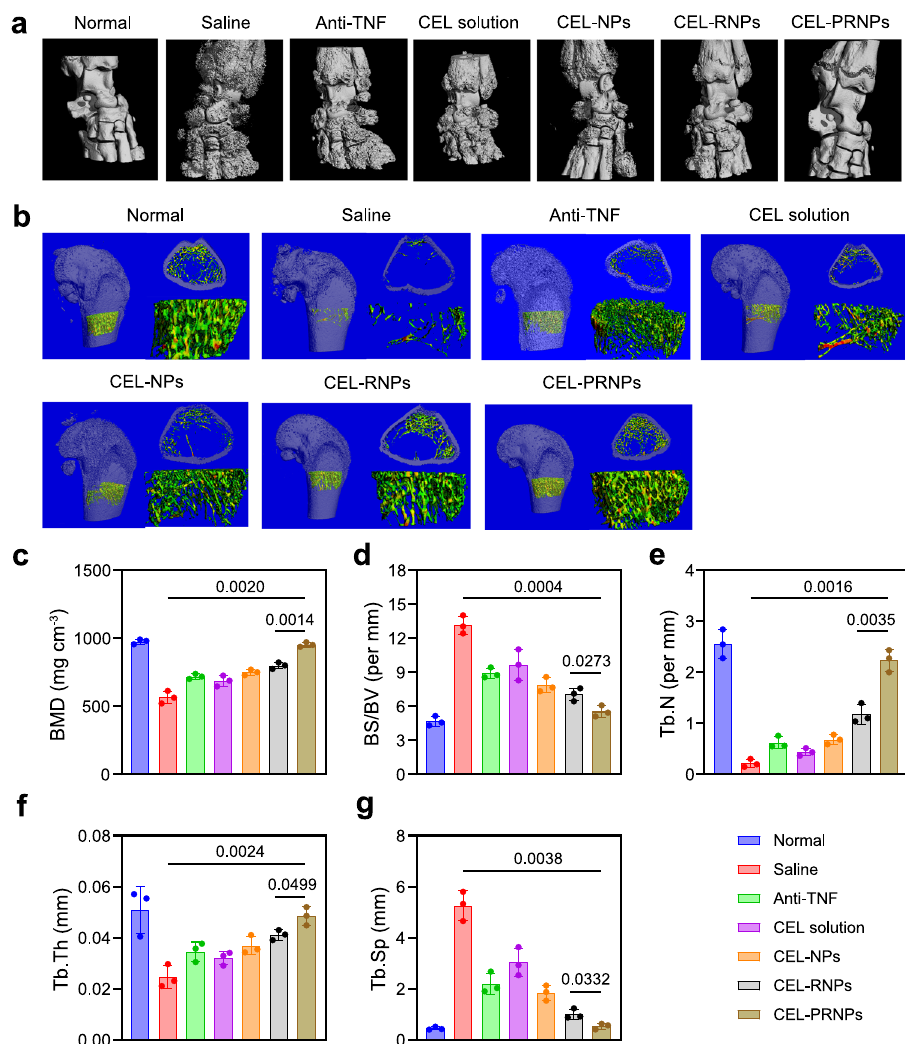
Fig. 9 CEL-PRNPs reverse bone erosion in rats with advanced arthritis. a Representative micro-CT images of the ankle joints at the endpoint of the experiment from different treatment groups in therapeutic ef fi cacy study ( n = 3 independent animals). b Representative micro-CT images of the trabecular in bone and the reconstructed trabecular structure ( n = 3 independent animals). c , d Quantitative micro-CT analysis of BMD ( c ) and BS/BV ( d ) of the ankle joints at the endpoint of the experiment. Data represent mean ± SD ( n = 3 independent animals). Statistical signi fi cance was determined by a two- sided Student ’ s t test. e – g Quantitative micro-CT analysis of trabecular number (Tb.N) ( e ), trabecular bone thickness (Tb.Th) ( f ), and